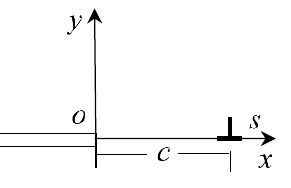
Figure 3. A screw dislocation near a semi-infinite crack.